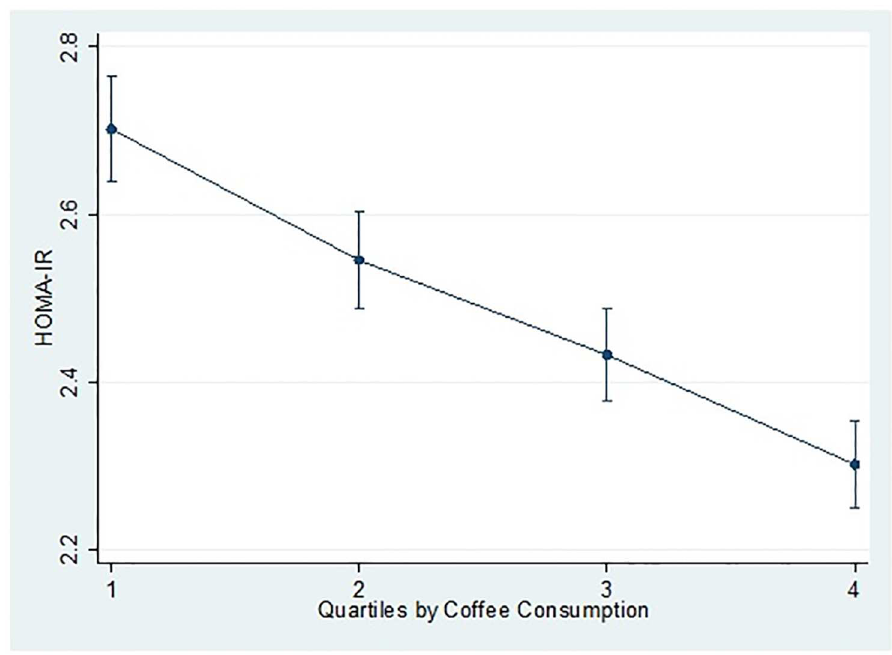
Fig 2. Least-squares means of HOMA-IR according to the frequency of coffee intake. (p for trend < 0.001). Abbreviations: HOMA-IR; the Homeostasis Model Assessment of Insulin Resistance. All data are weightedto the Korea’snationaladult population.Multiplelinear regression,model is used, adjustingfor age (10 (cid:20) years < 20,20 (cid:20) years < 30,30 (cid:20) years < 40,40 (cid:20) years < 50, (cid:21) 50 years) and BMI (continuous).